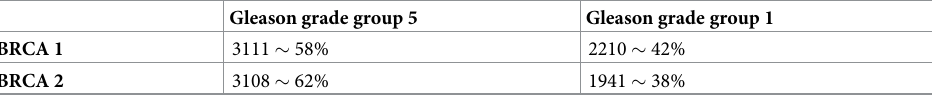
Table 3. Data count and distribution of classes after the removal of highly similar DNA sequences.